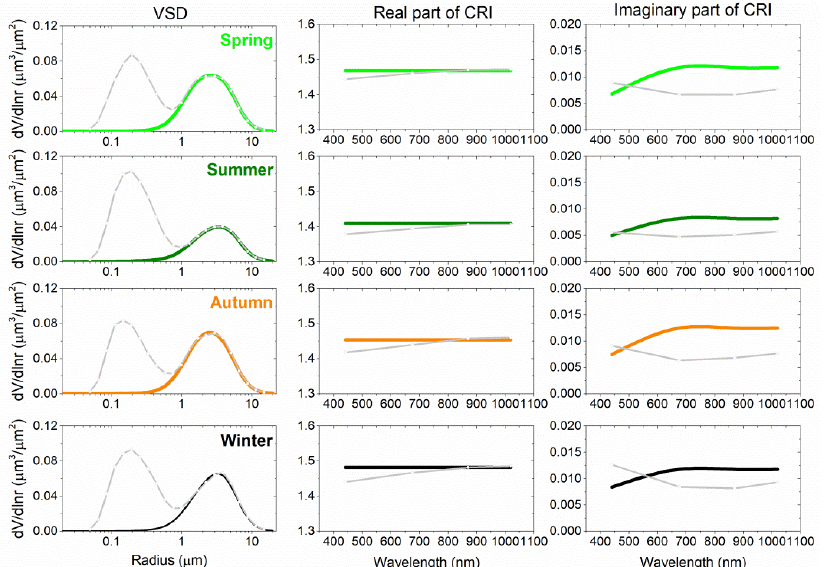
Figure 6. Seasonal variation of coarse-mode VSD and CRI in SONET Chengdu site. The grey line refers to the total parameters. The corresponding parameters are listed in Table 2.